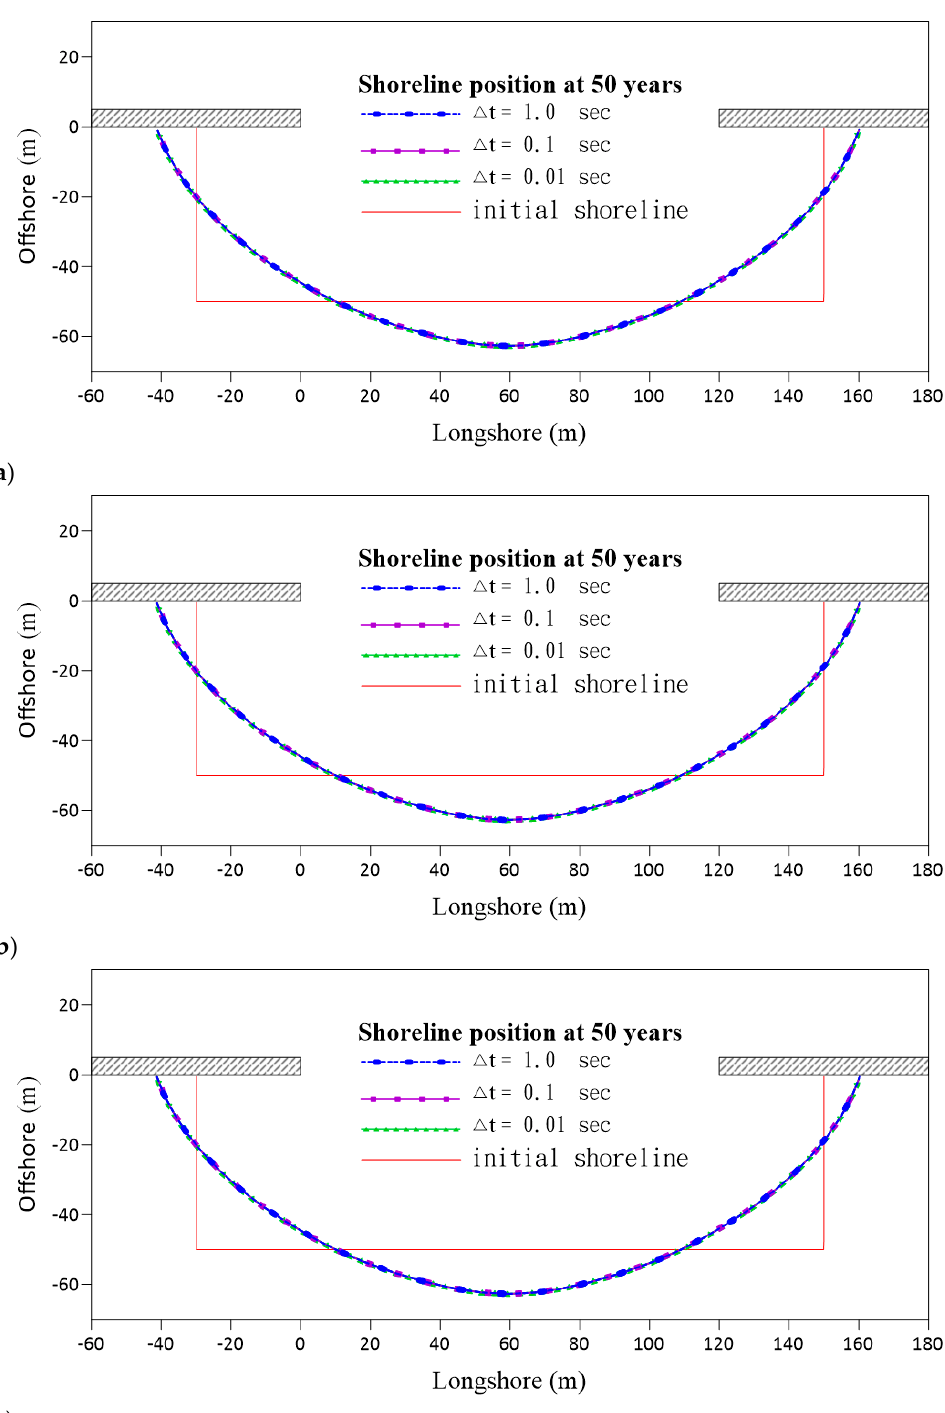
Figure 6. The numerical results and comparison by using different ∆t for ( a ) m = 109, ( b ) m = 179 and ( c ) m = 229.